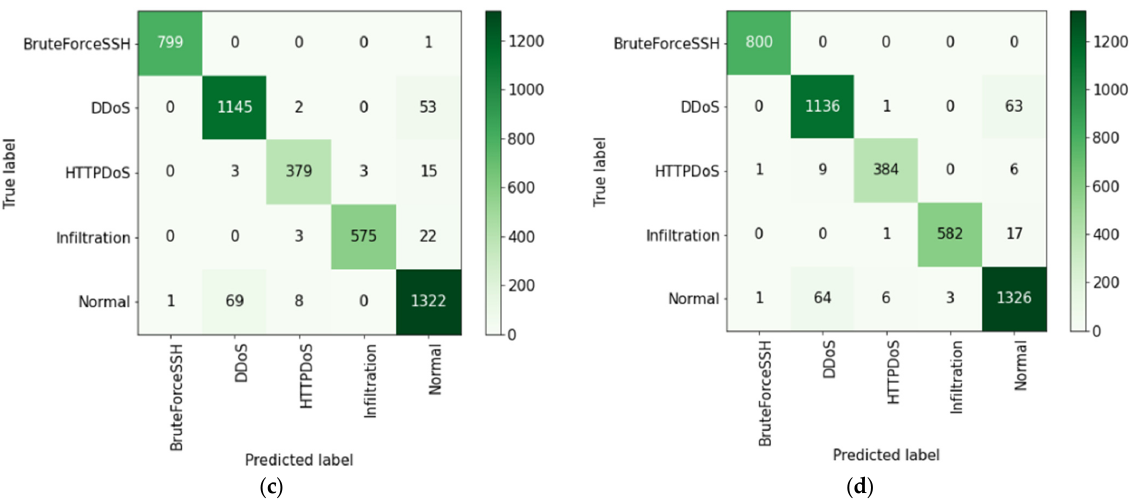
Figure 5. Confusion matrix for each NIDS using ISCXIDS2012. ( a ) CNN; ( b ) DNN; ( c ) HAST-I; ( d ) Proposed.